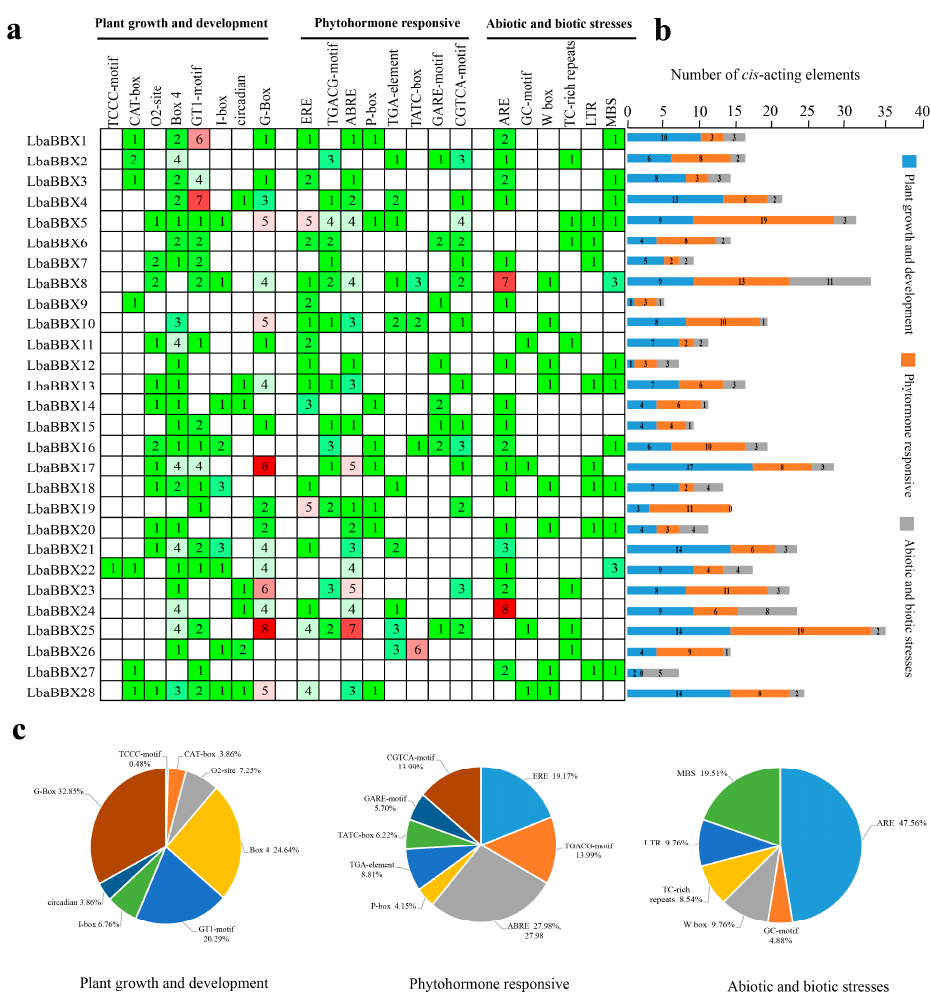
Figure 5. Identification of cis -elements in promoter regions of LbaBBXs . ( a ) Three categories of cis -acting elements in the LbaBBXs. Different numbers and color of the gird representing the number of different elements in these LbaBBXs . ( b ) Histogram of the cis-acting elements in each LbaBBX gene. The blue rectangle represents plant growth and development responsive cis -elements, the orange rectangle represents phytohormone responsive cis -elements, and the gray rectangle represents abiotic and biotic stress responsive cis-elements. ( c ) Pie charts of different sizes indicated the ration of each promoter element in each category, respectively.